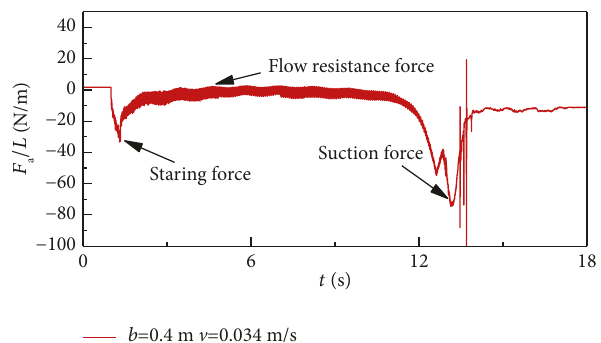
Figure 16: Additional hydrodynamic load evolution during the water-exit process.